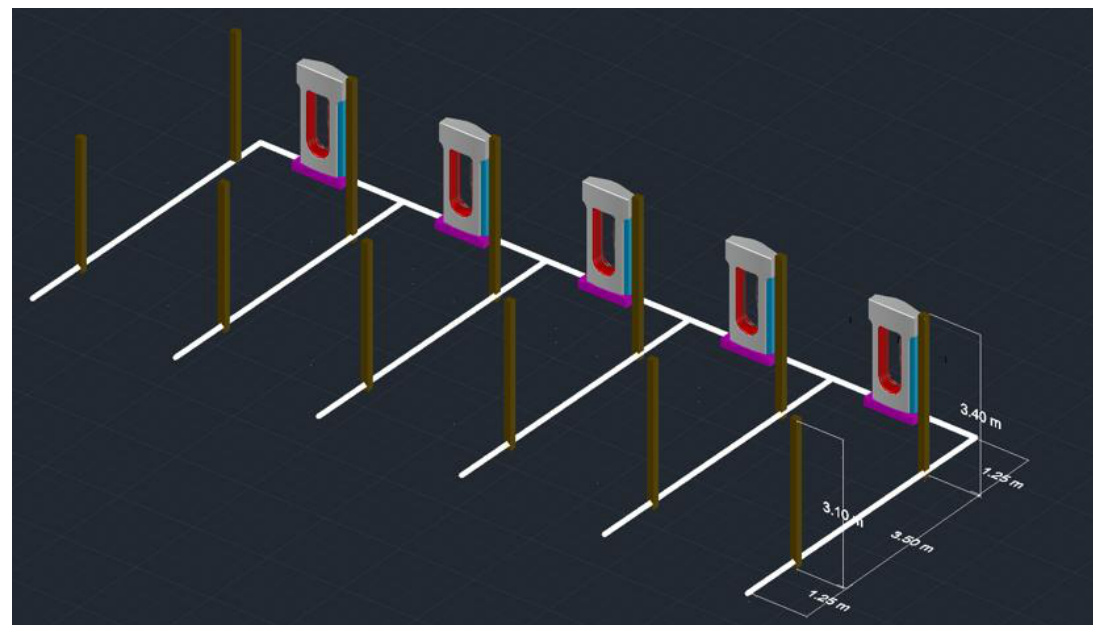
Figure 1. Single-Span System Post Configuration.